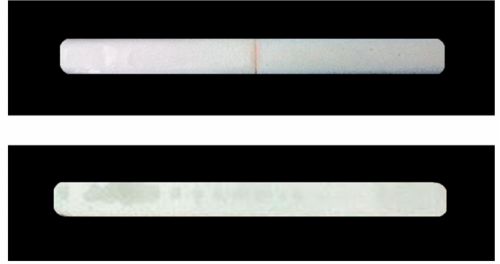
Figure 3. Notched samples before and after